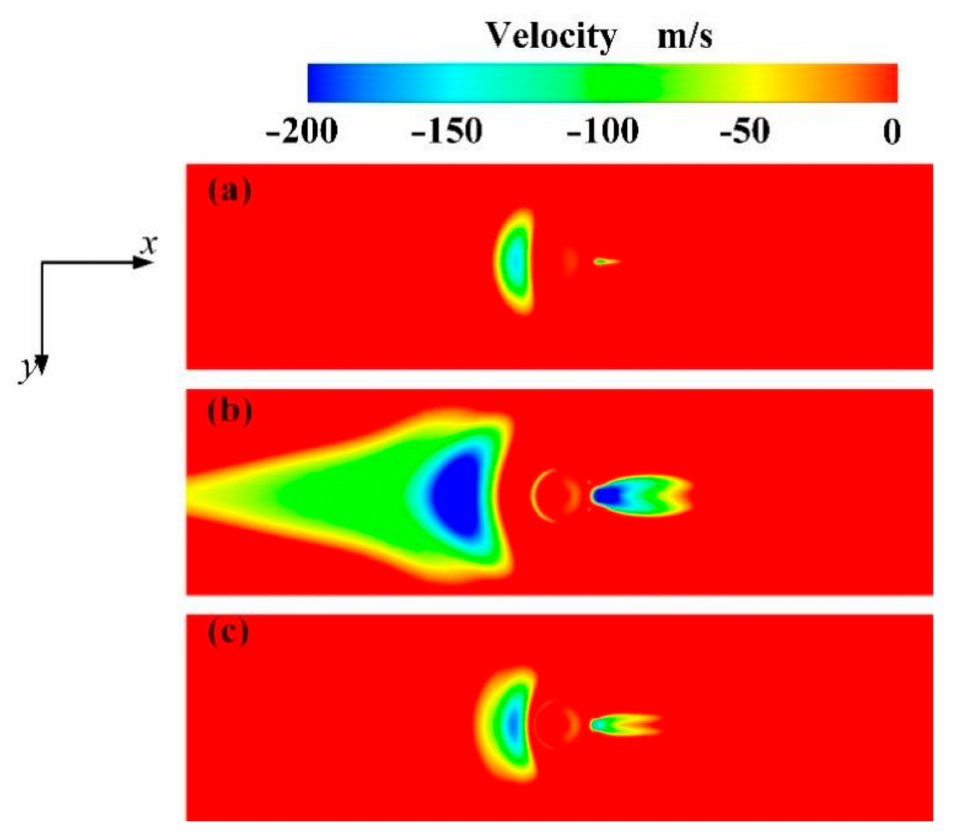
Figure 19. Velocity contour diagram of the reflux zone for ( a ) Case a, ( b ) Case b, and ( c ) Case c at z / D =